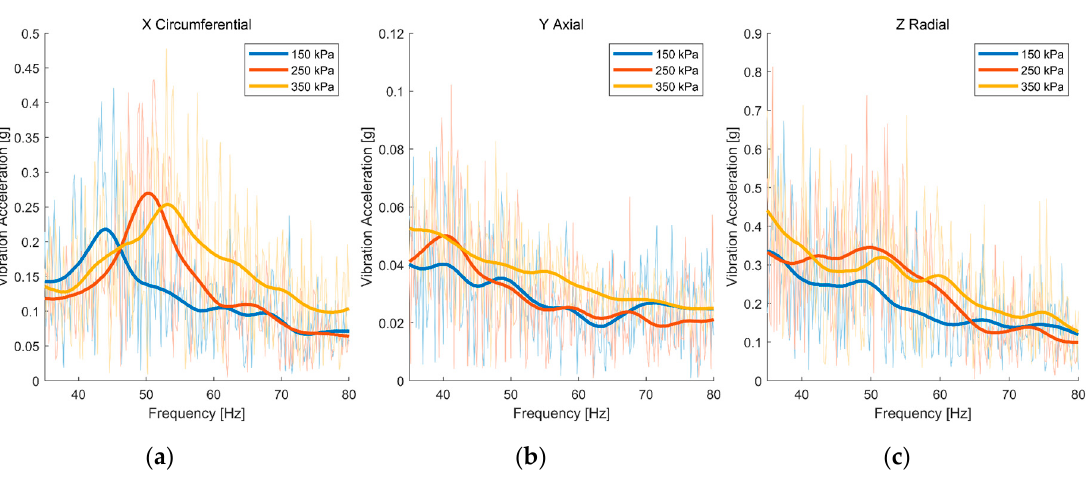
Figure 7. Amplitude-frequency curve of accelerometer C (rim well) in three directions: ( a ) Circumferential direction; ( b ) axial direction; ( c ) radial direction.